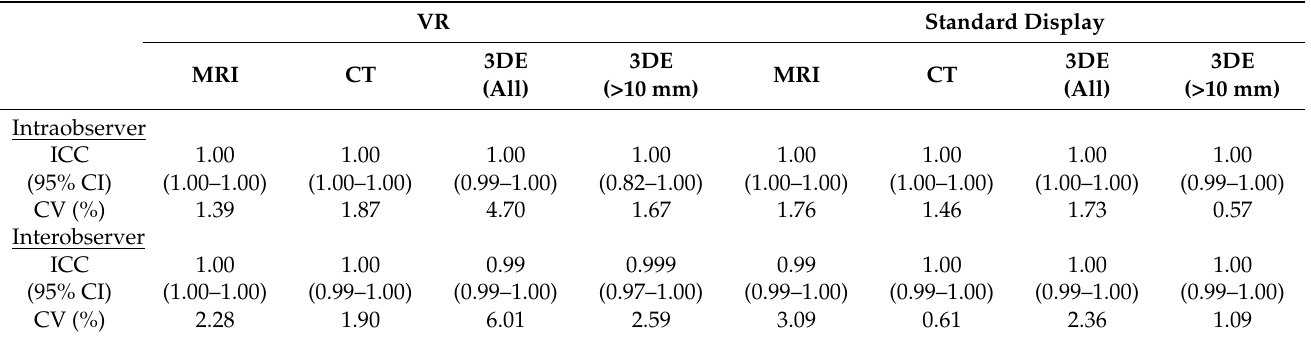
Table 1. Inter- and intraobserver variability of measurements in VR and standard display. VR Standard